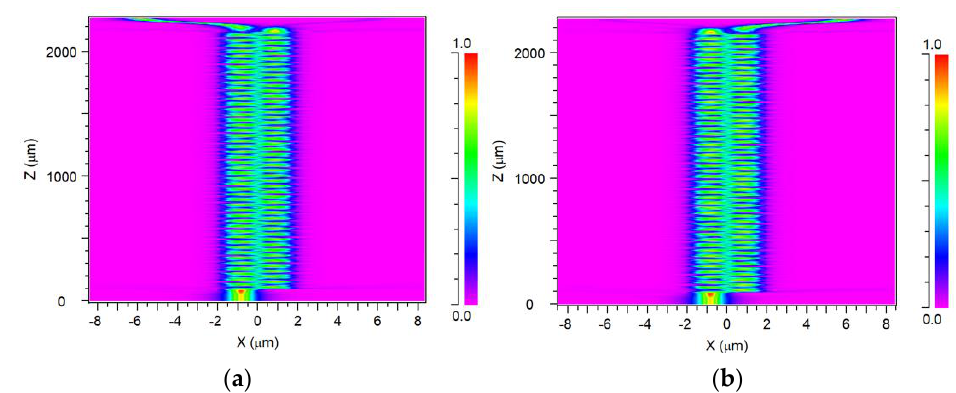
Figure 6. Intensity distributions of the two-channel SiN MMI demultiplexer: ( a ) λ 1 = 1540 nm (port 1); ( b ) λ 2 = 1560 nm (port 2).